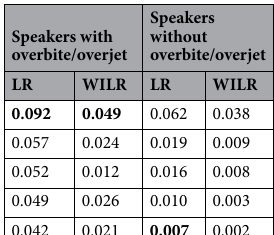
Speakers without